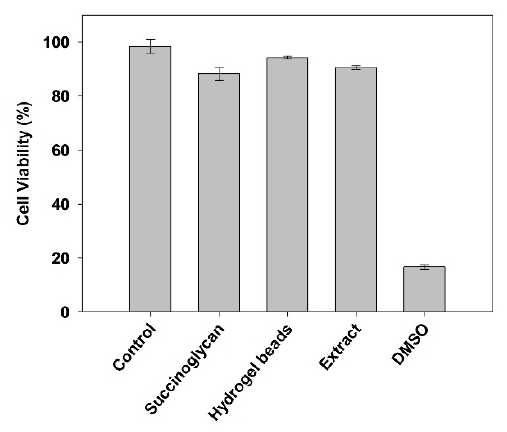
Figure 9. Human embryonic kidney 293 (HEK293) cell viability percentage following exposure to control, succinoglycan, dried Fe 3 + -SG hydrogel beads, extract, and DMSO.